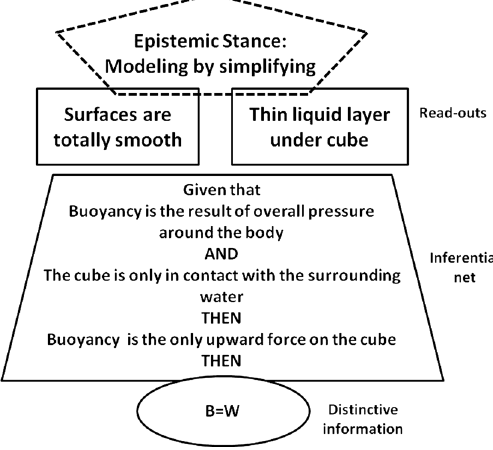
FIG. 4. Schematic diagram of the projection described in S 2 .